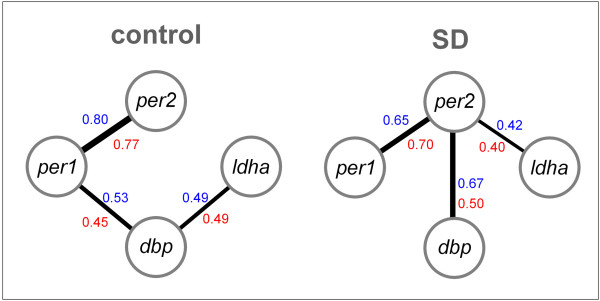
Significant correlations among forebrain expression levels of the four genes examined during control (left; n = 48) and sleep deprivation (SD; right; n = 48) conditions. Only those correlations between gene pairs are indicated that remained significant after partialling out the influence of the other two. In blue the Pearson's correlation coefficients, in red the partial correlation coefficients. Line thickness corresponds to correlation strength.